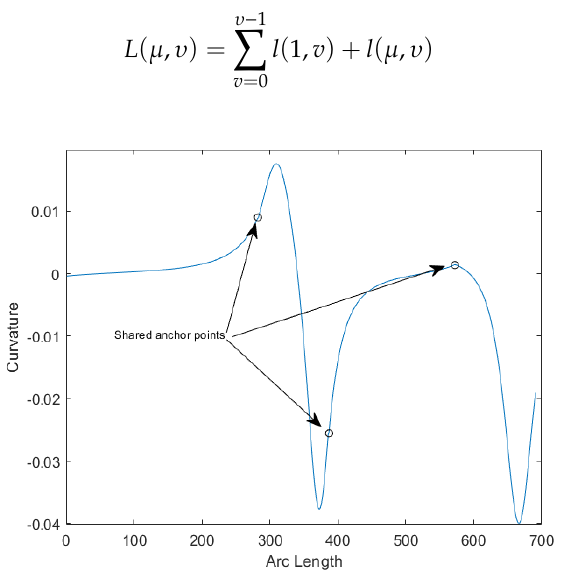
2 PCBC) are continuous over the entire